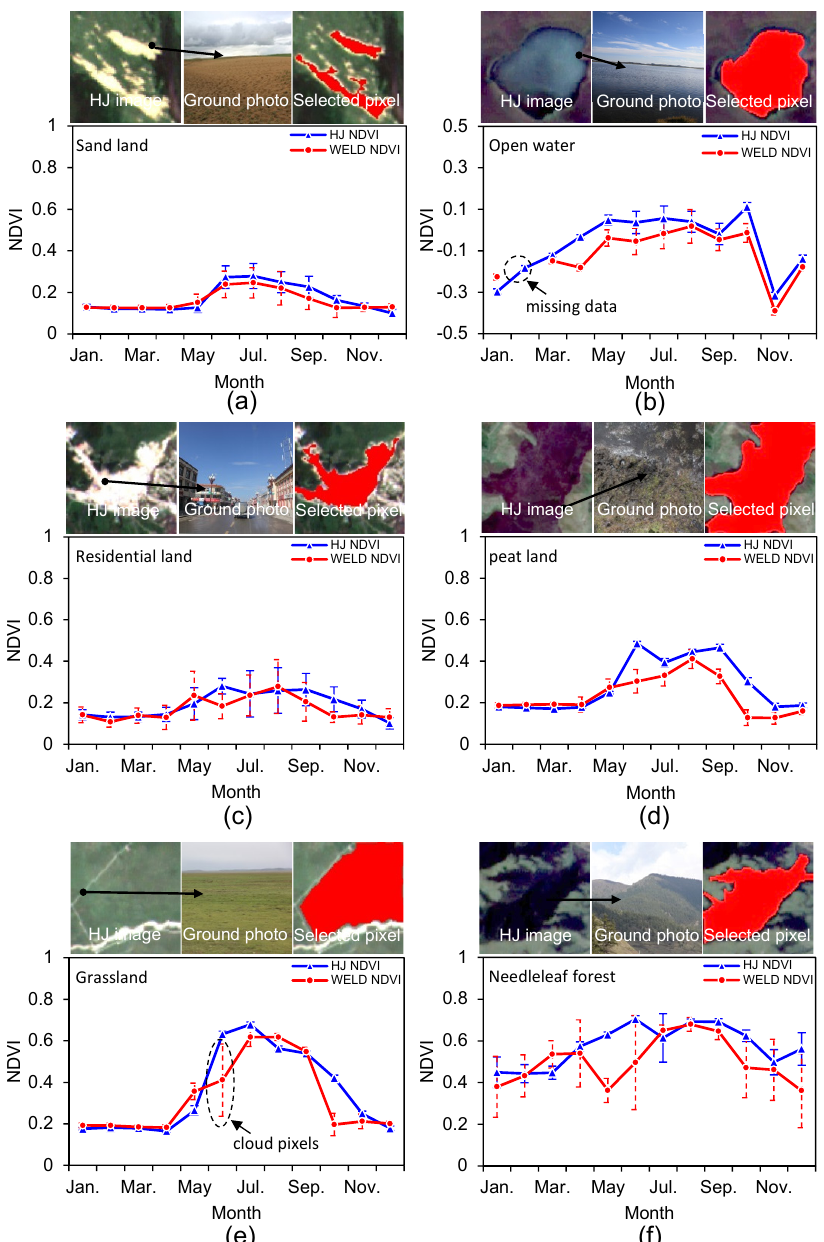
Figure 9. Monthly mean TOA NDVI profiles of six typical land covers ( a – f ) and their standard deviation values at corresponding window locations extracted from the monthly HJ and WELD composites. The six ground photos show the actual ground land cover types for each NDVI temporal profile.